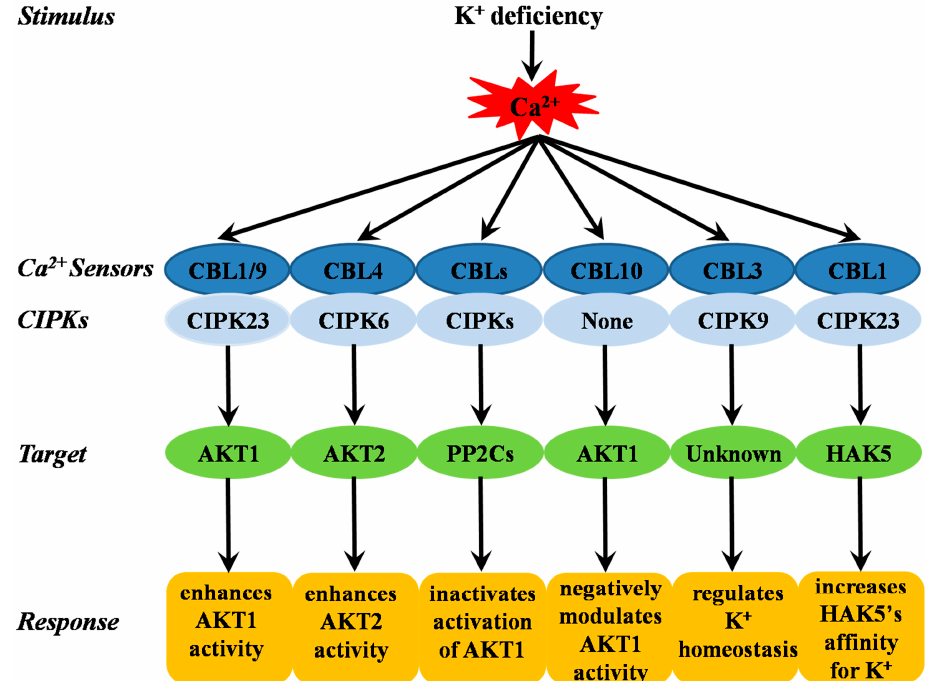
Figure 2. The summary of CBL-CIPK complex involved in response to K +